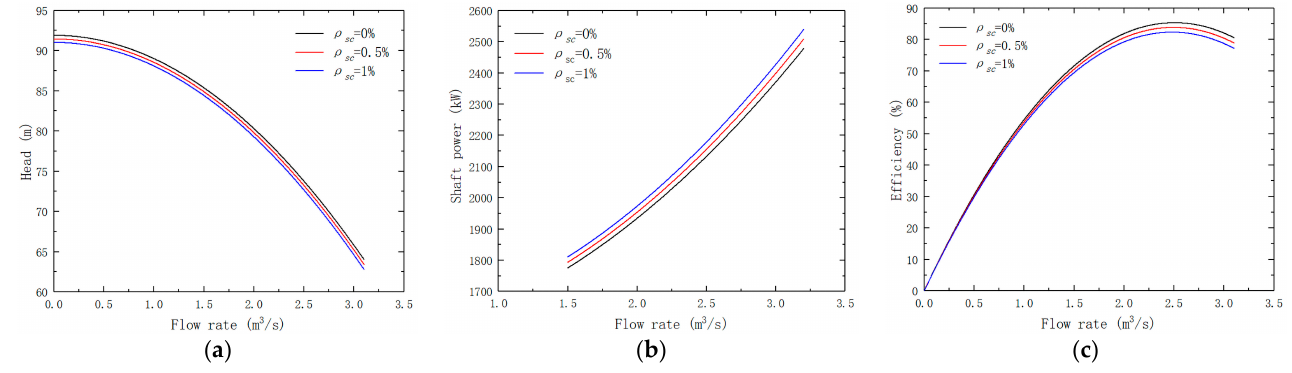
Figure 11. Characteristic curves of centrifugal pump with sediment concentrations of 0%, 0.5%, and 1%: ( a ) flow-head ( Q-H ) curve; ( b ) flow-shaft power ( Q-N ) curve; ( c ) flow-efficiency ( Q- η ) curve.